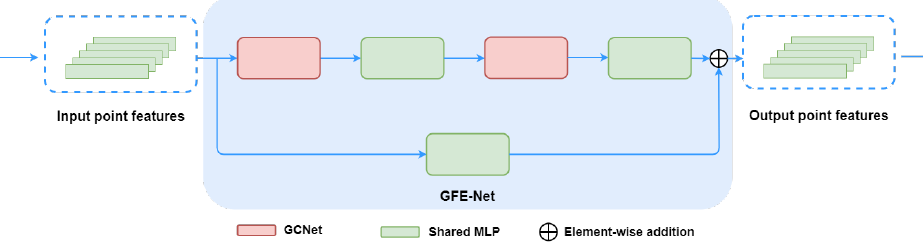
Figure 6. The details of the network architecture of GFE-Net. The input point features go through GCNet and shared MLP to extract high-level features with global information. Furthermore, a shared MLP branch is used to update the original low-level feature of local information. After that, the high- level features and the low-level features are combined with a merge operation to avoid the lack of low-level feature